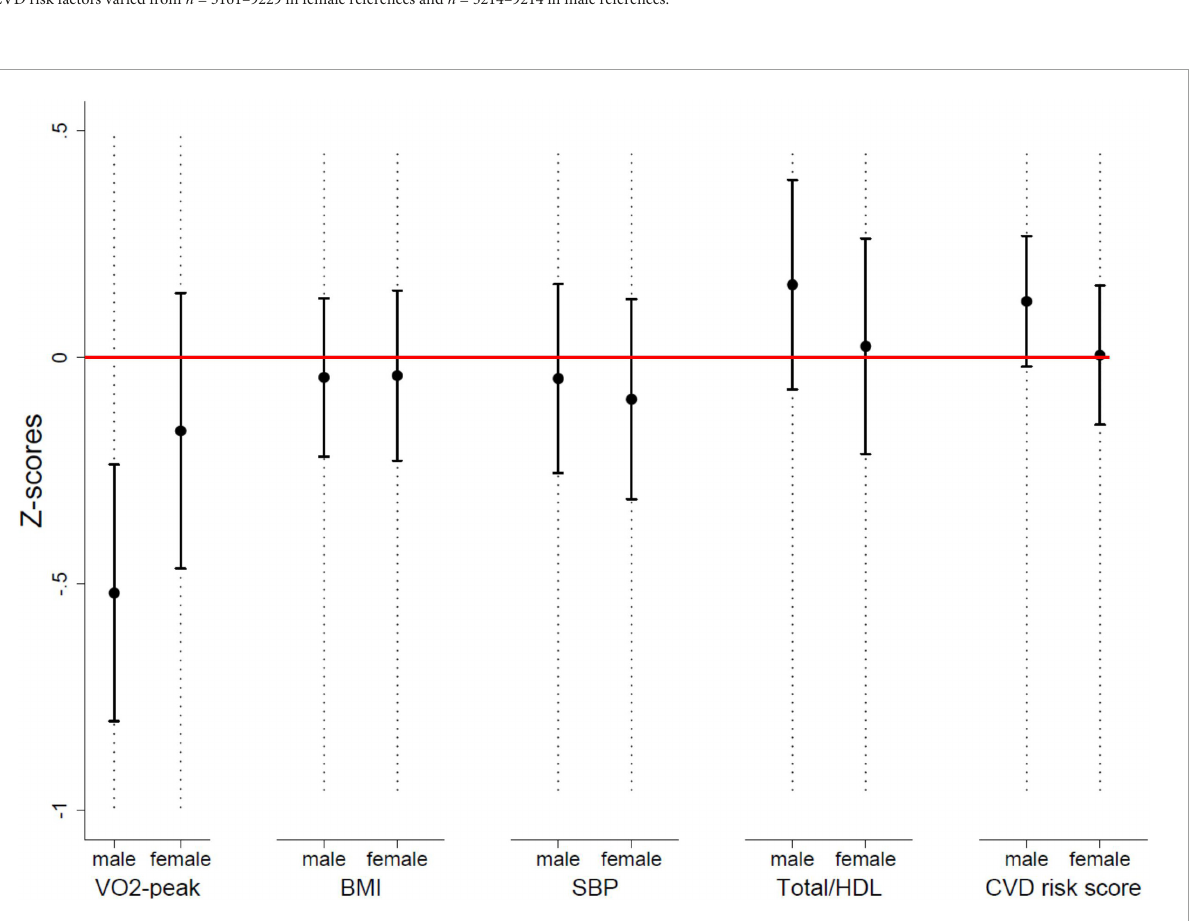
FIGURE2 Mean Z -scores with 95% CI for single CVD risk factors and the CVD risk score, stratified by sex. BMI, body mass index (kg/m 2 ); CVD, cardiovascular disease; SBP, systolic blood pressure; Total/HDL, total-cholesterol/HDL-cholesterol; VO2-peak, peak oxygen